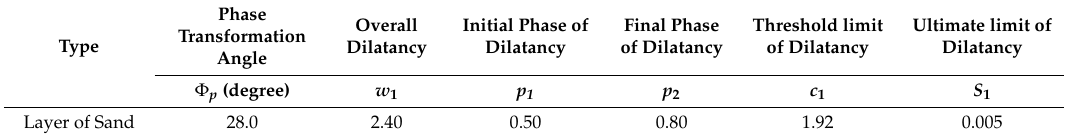
Table 3. Liquefaction characteristics parameters of the soil used for the simulation. Parameter designations are illustrated in [9].